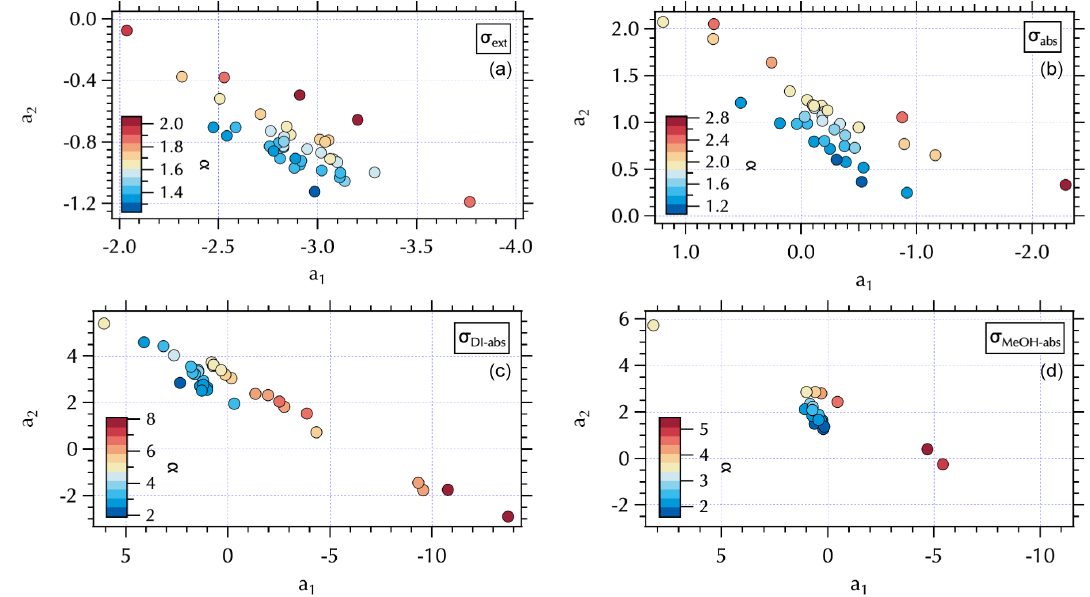
Figure 7. Maps of α in a 2 vs. a 1 space: σ ext (a) , σ abs (b) , σ DI-abs (c) , and σ MeOH-abs (d)